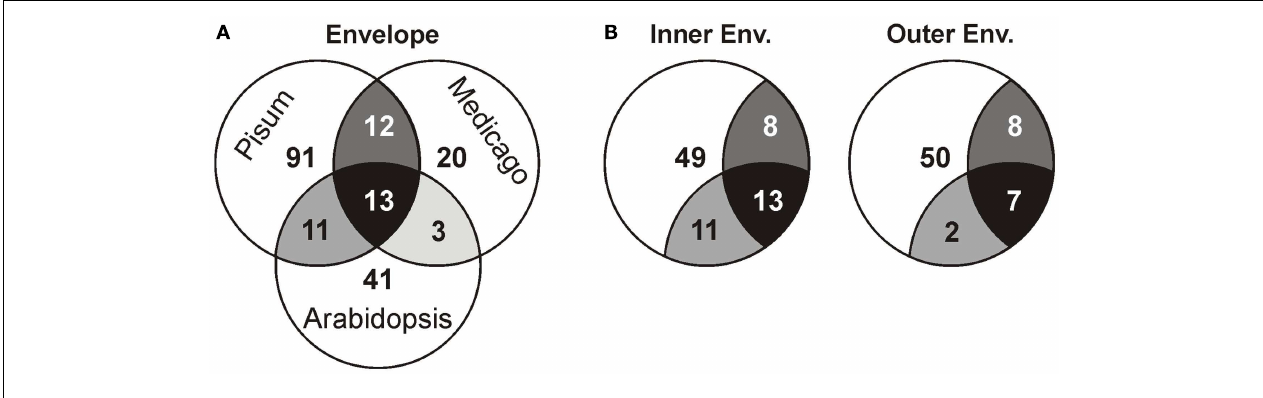
of the circles in theVenn diagram. (B) The overlap of the proteome determined for A. thaliana , M. sativa mixed envelope and P. sativum inner (left) and outer (right) envelope was analyzed and the color code is taken from (A) .